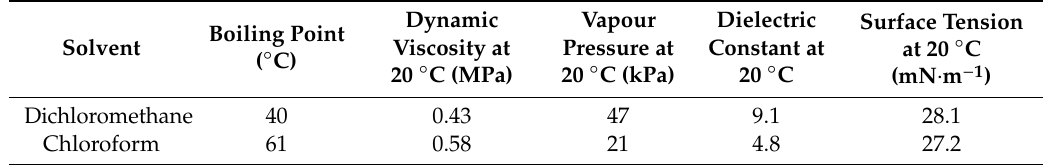
Table 2. Physical properties of solvents.